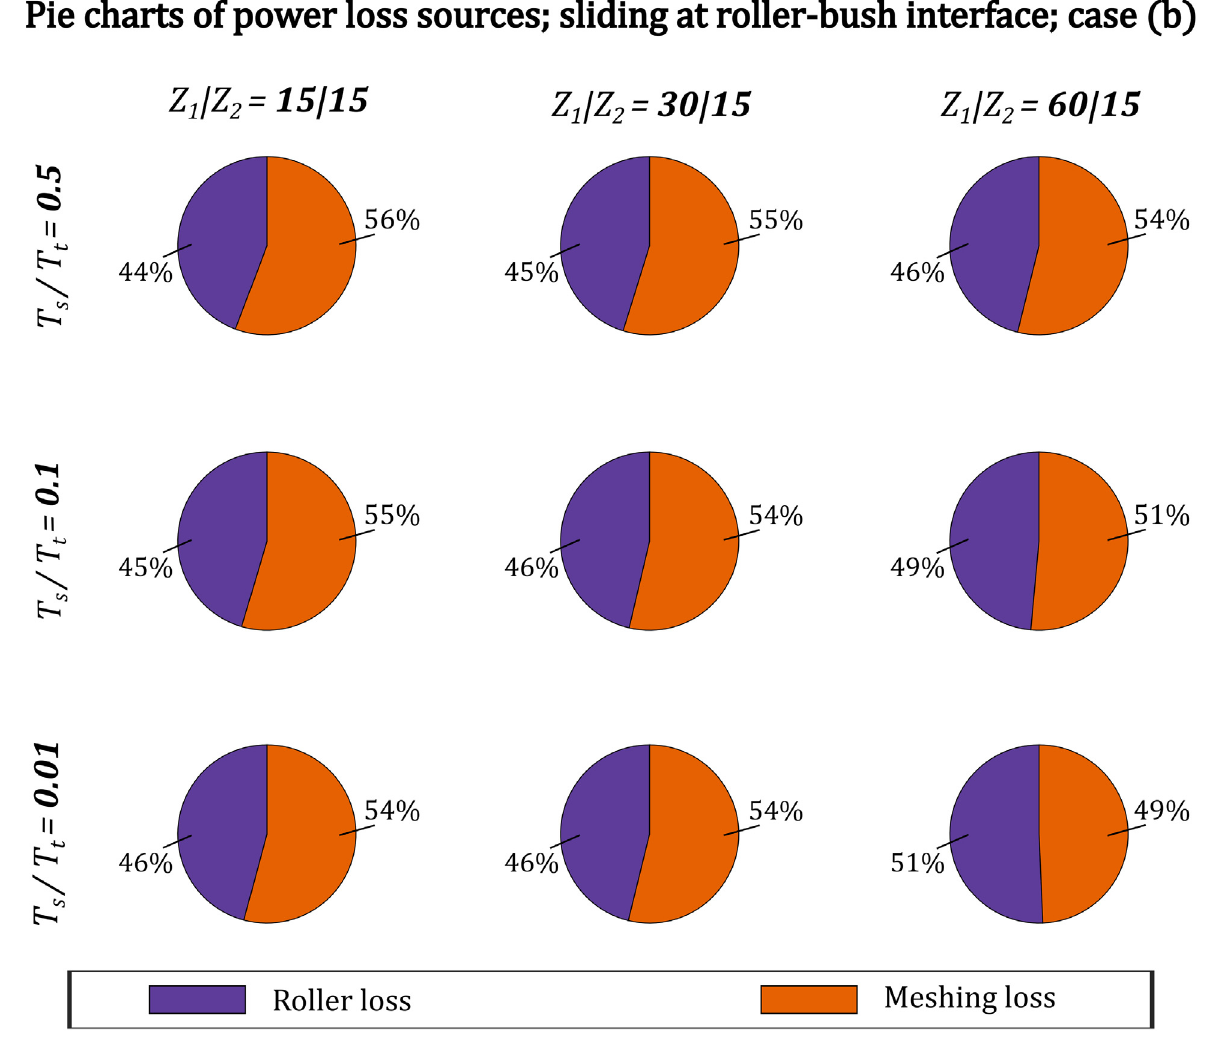
Fig. 21. Pie charts for case (b).